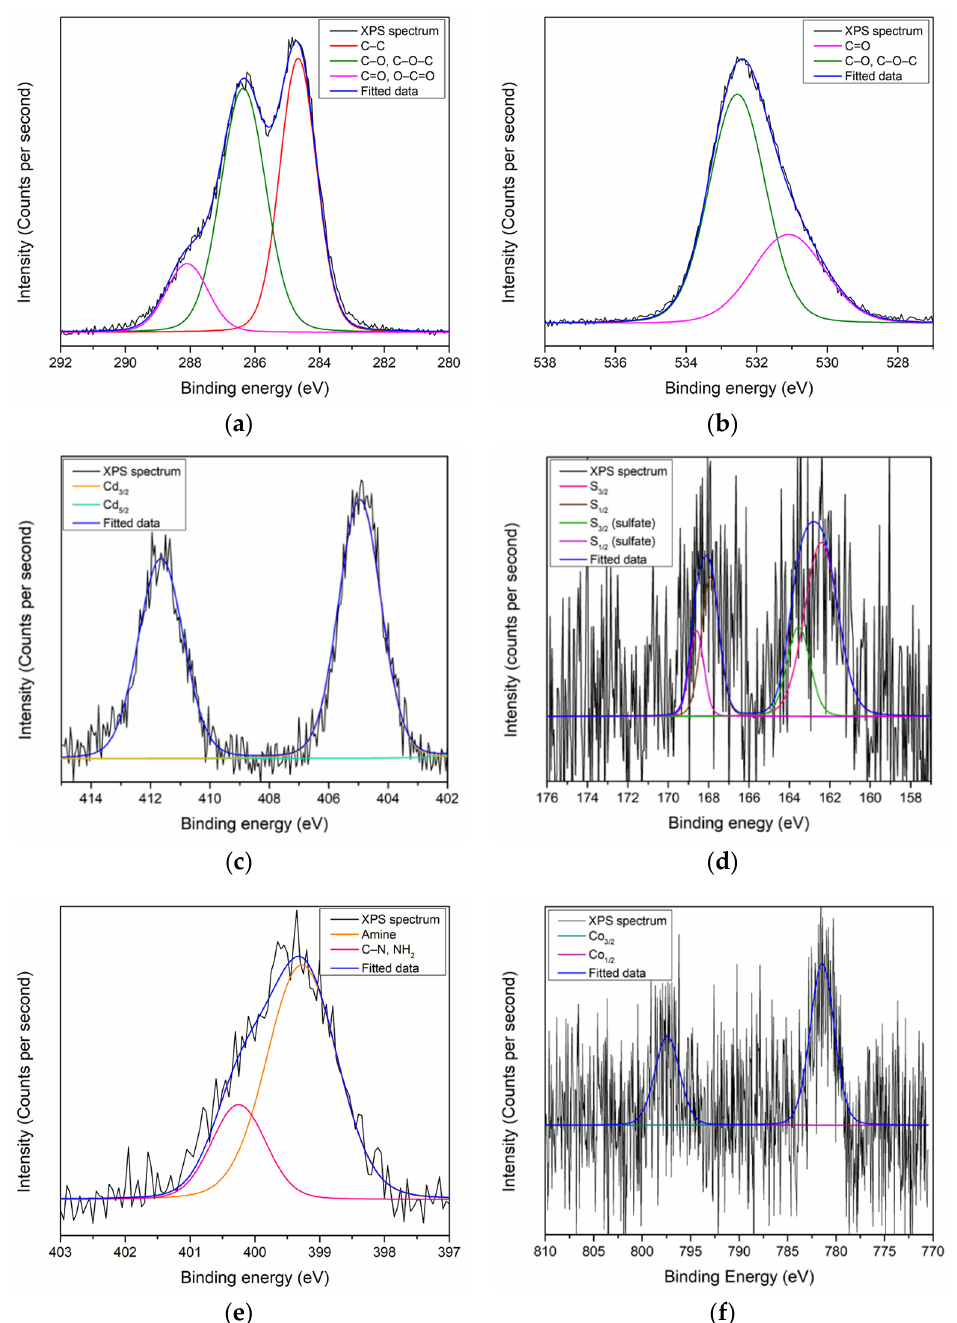
Figure 7. XPS narrow scan spectra of CdS QD–chitosan–GO after contact with Co 2+ for ( a ) C 1s; ( b ) O 1s; ( c ) Cd; ( d ) N 1s; ( e ) S 2p; and ( f ) Co 2p.